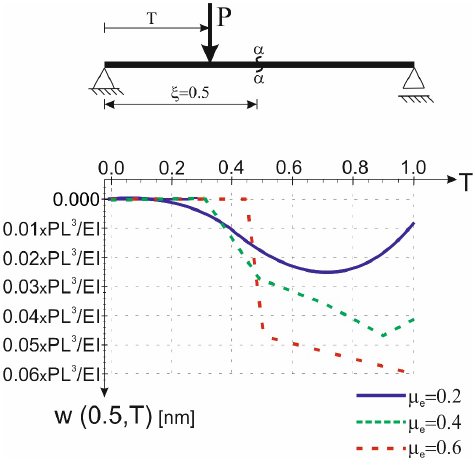
Figure 8: Stress gradient model. Vibrations of the beam in the middle cross section if 0.01 g η = .